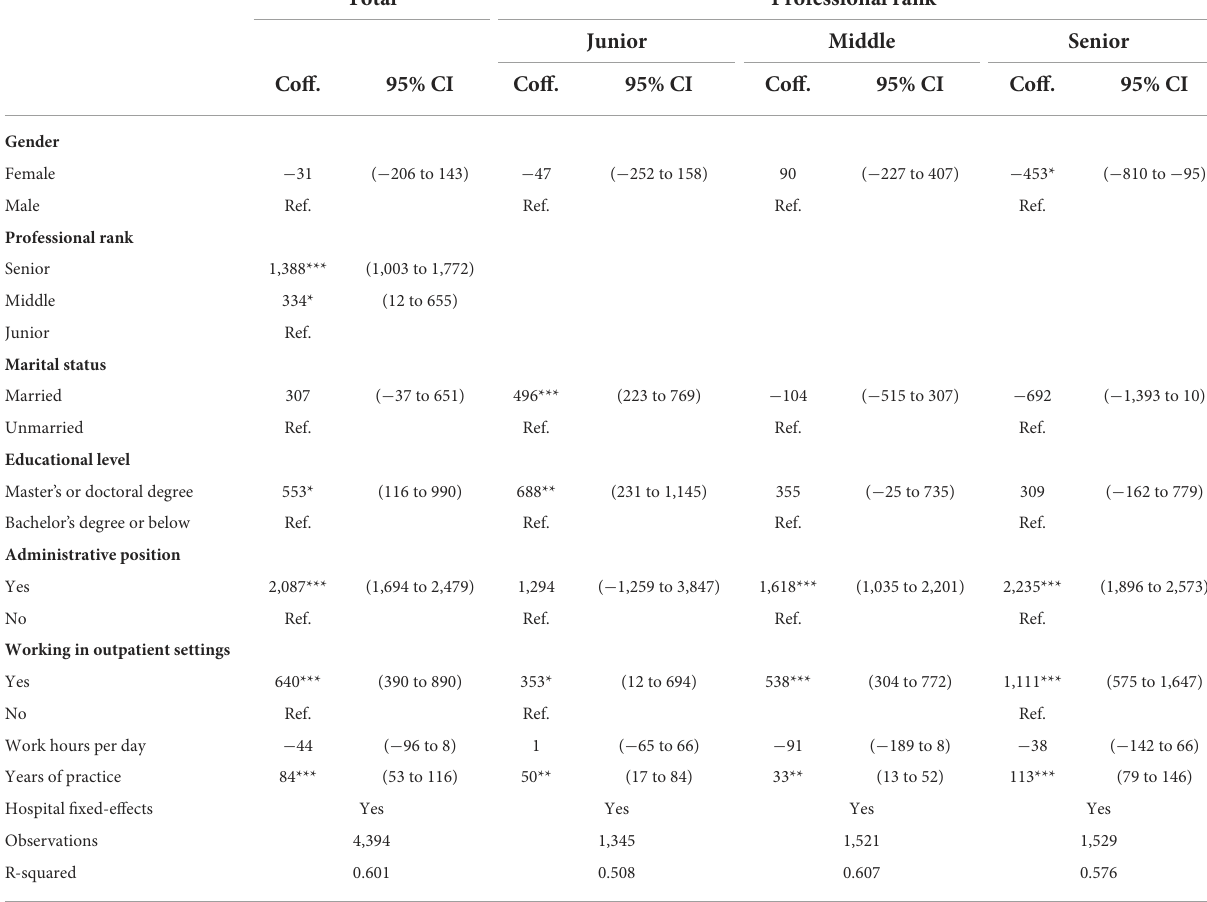
Table A1 Multiple linear regression results of gender income differences by professional